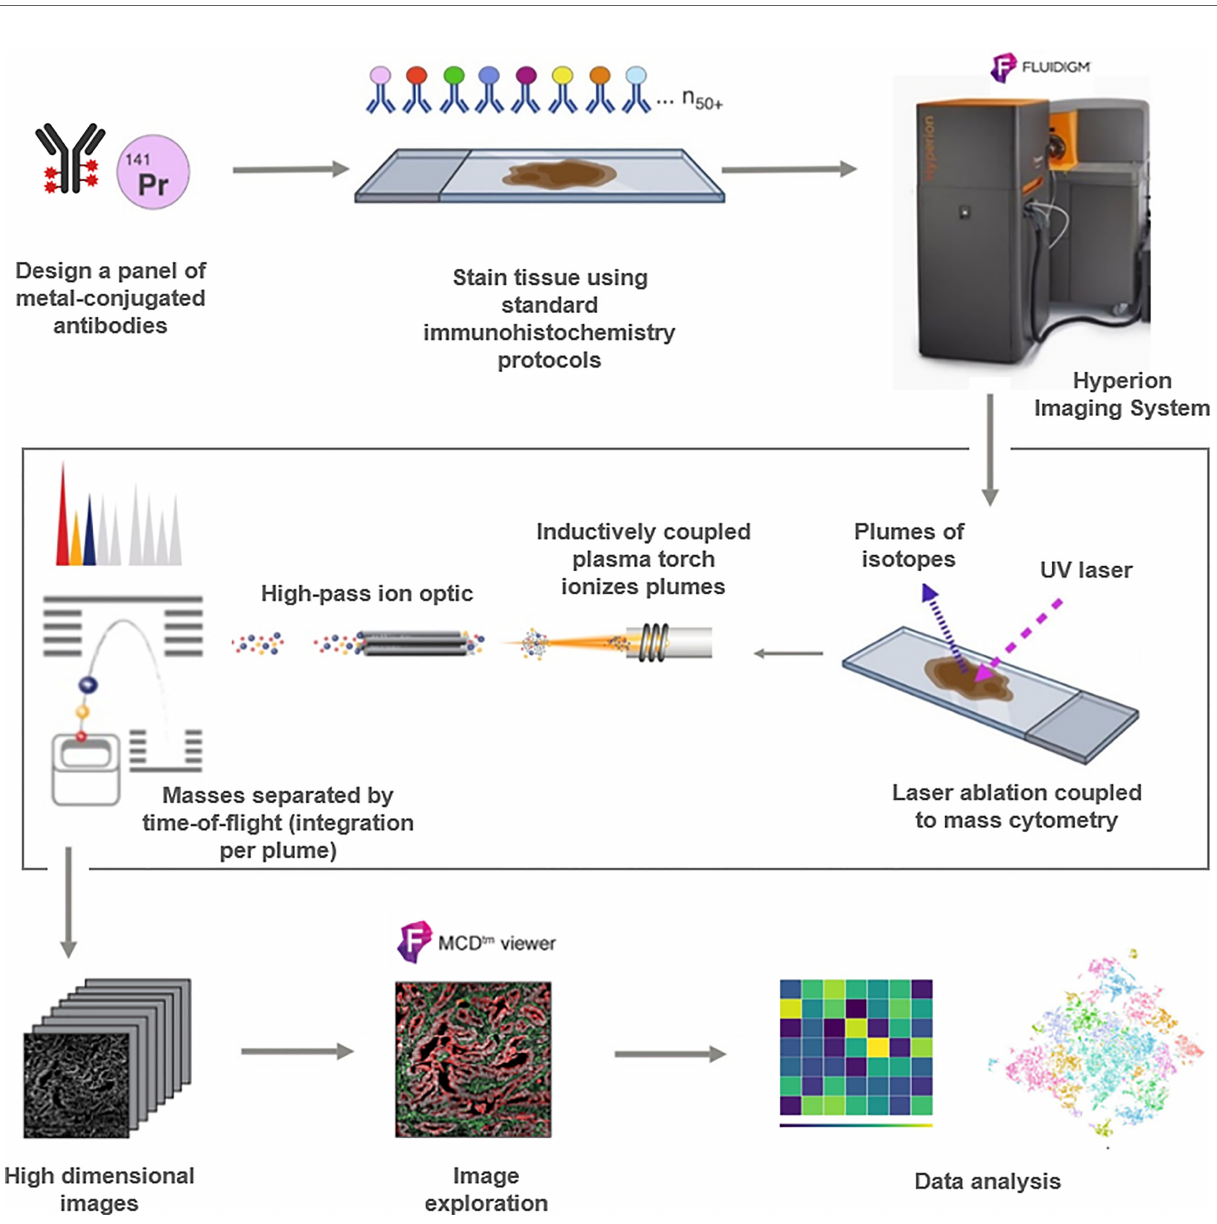
FIGURE 1 | Schematic work fl ow of the Hyperion (Fluidigm) imaging mass cytometry (IMC) technique for protein pro fi ling. Samples processing and design of the antibodies panel are followed by IMC staining and data acquisition in order to use the output data for